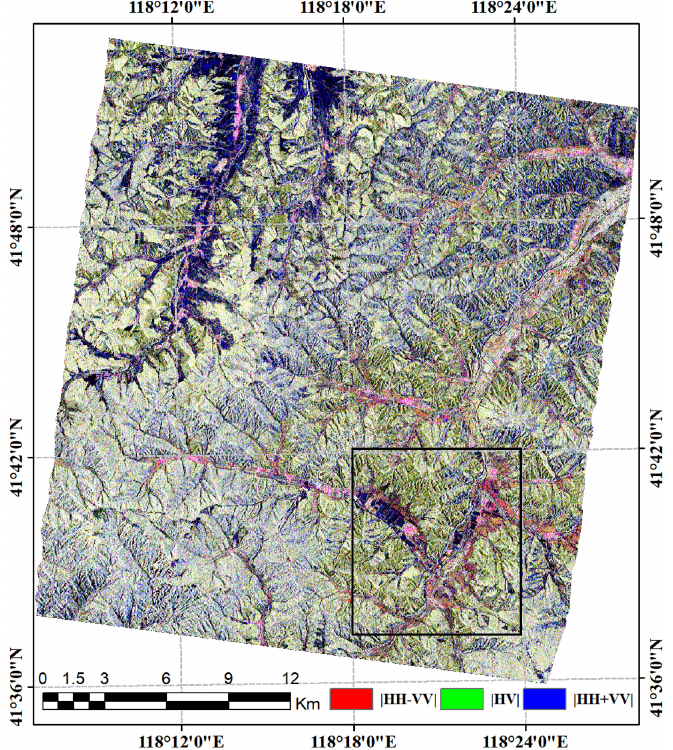
Figure 9. The Pauli RGB after RTC based on RPC model.